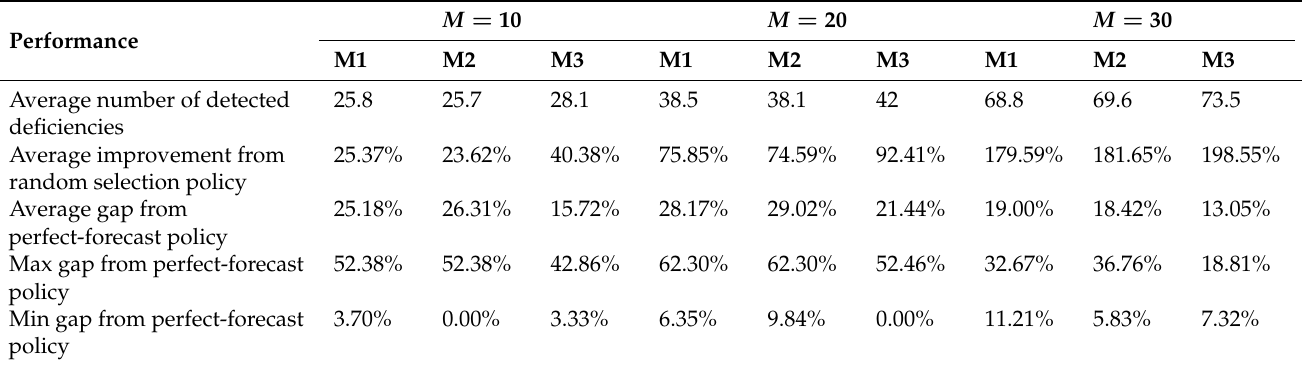
Table 7. Performances of the optimization model based on the prediction results of M1, M2, and